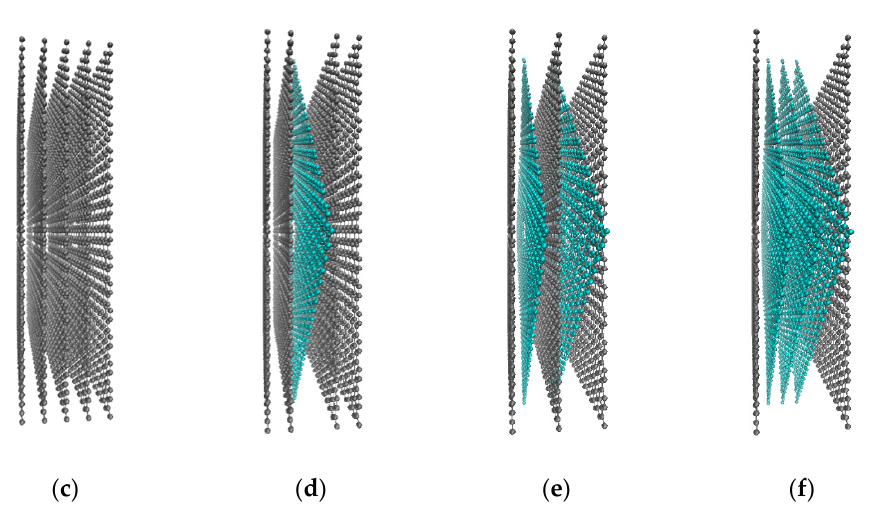
Figure 2. Pore shapes and patterns used in the simulation. ( a ) Circular shaped pore; ( b ) non-circular shaped pore; ( c ) representation of base pattern; ( d ) representation of pattern 1; ( e ) representation of pattern 2; ( f ) representation of pattern 3. Angled graphene sheets are represented in cyan color. Table 1. Shows the different patterns of graphene multilayer used in this study ( θ —represents the angled graphene sheet).